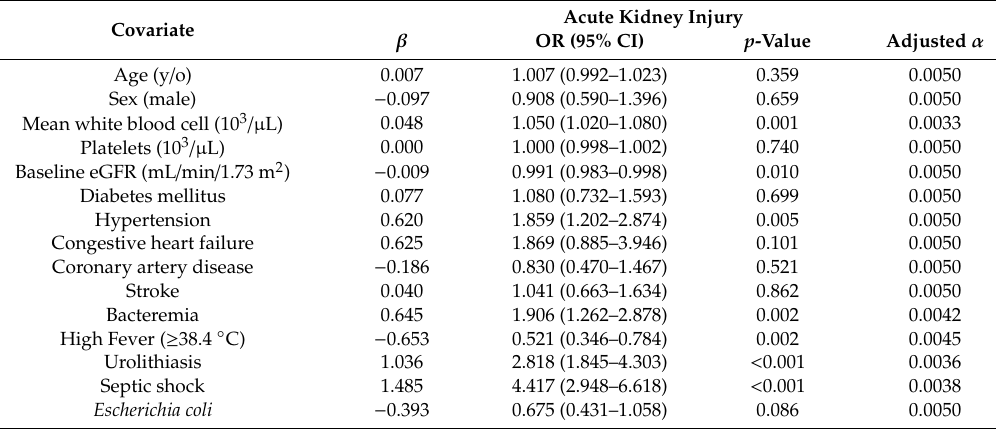
Table 3. Multivariate logistic regression analyses of factors related to acute kidney injury in patients with urinary tract